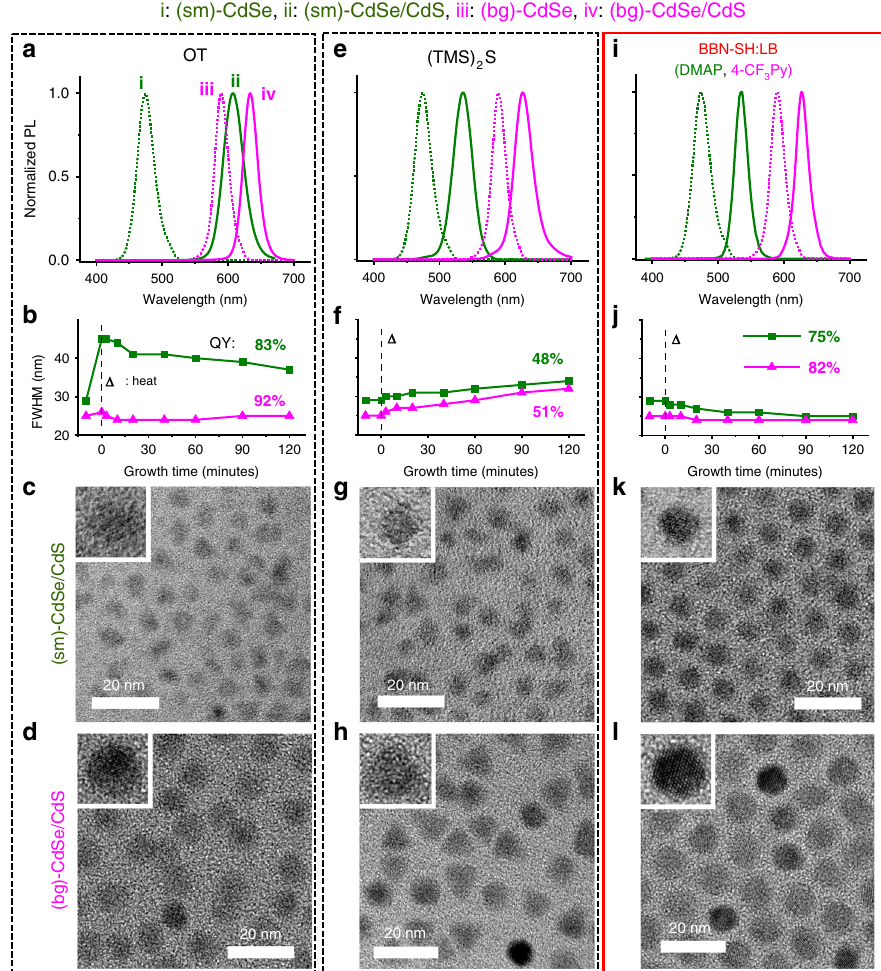
Fig. 2 [BBN-SH:LB]-based high-quality shell growth in different sizes of QD cores. [BBN-SH:LB] enables a systematic growth of high-quality shells while the QDs produced with conventional precursors show suboptimal quality for all ((TMS) 2 S) or some (OT) of the sizes. a , e , i PL spectra of core (dotted line) and core-shell QDs (solid line). b , f , j Evolution of FWHM during growth ( Δ : the reaction temperature was increased for each shell deposition process, see Supplementary Table S4 for detail condition). c , d , g , h , k , l TEM images (inset: HRTEM images) of (sm)-CdSe/CdS ( c , g , k ) or (bg)-CdSe/CdS core/shell QDs ( d , h , l scale bar: 20 nm). When using BBN-SH, tight size distribution (FWHM < 25 nm) is obtained for both (sm)- and (bg)-CdSe cores, whereas OT produces QDs with narrow FWHM only from (bg)-CdSe cores. In the case of (TMS) 2 S, the emission of the fi nal QDs is broader (FWHM > 32 nm) for both small and big cores. The TEM images con fi rm narrow size distribution, shape uniformity, and high crystallinity for all size QDs produced with BBN-SH. The structural quality of these QDs is comparable to the QDs grown with OT from big